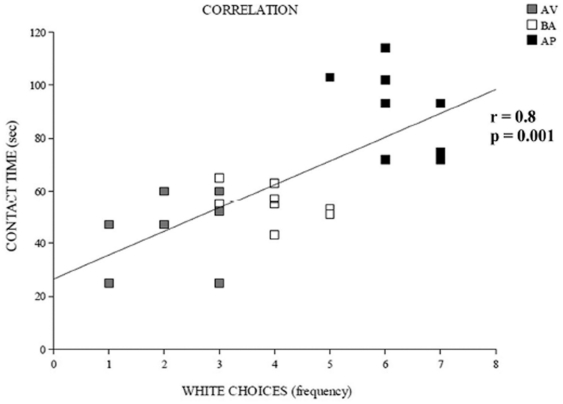
Correlation between frequency of white choices in the A/A Y-Maze (abscissa) and contact time of object in the OF (ordinate).A positive significant correlation has showed in the scatter plot. Abbreviations: AV: avoiding animals; BA: balancing animals; AP: approaching animals.